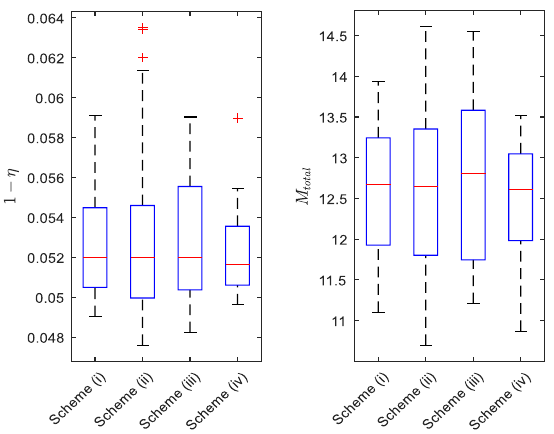
Figure 3. Fitness distribution (filtered of 30 runs) for MOALO approaches.